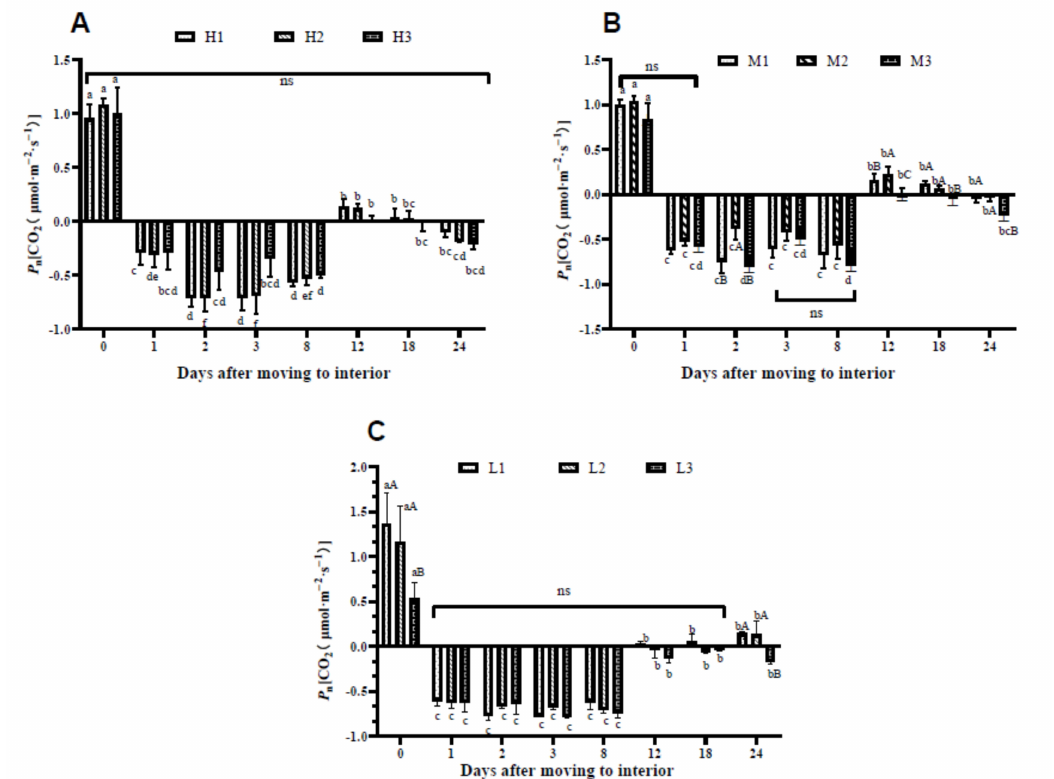
Figure 2. Net photosynthetic rate [CO 2 ( µ mol · m − 2 · s − 1 ) of Anthurium × ‘Red’ after placement in interior rooms. Where H ( A ), M ( B ), and L ( C ) represent PPFDs at 550, 350, and 255 µ mol · m − 2 · s − 1 , respectively. The numeric values 1, 2, and 3 represent the bottom old leaf, center mature leaf, and the top young expanded leaf, respectively. Vertical lines at each bar are the standard errors, and ns represent the non-significant differences at three leaf positions Different lowercase and uppercase letters represent significant differences among leaves in tested days and leaf positions on the same day, respectively, based on Tukey HSD test at P < 0.05